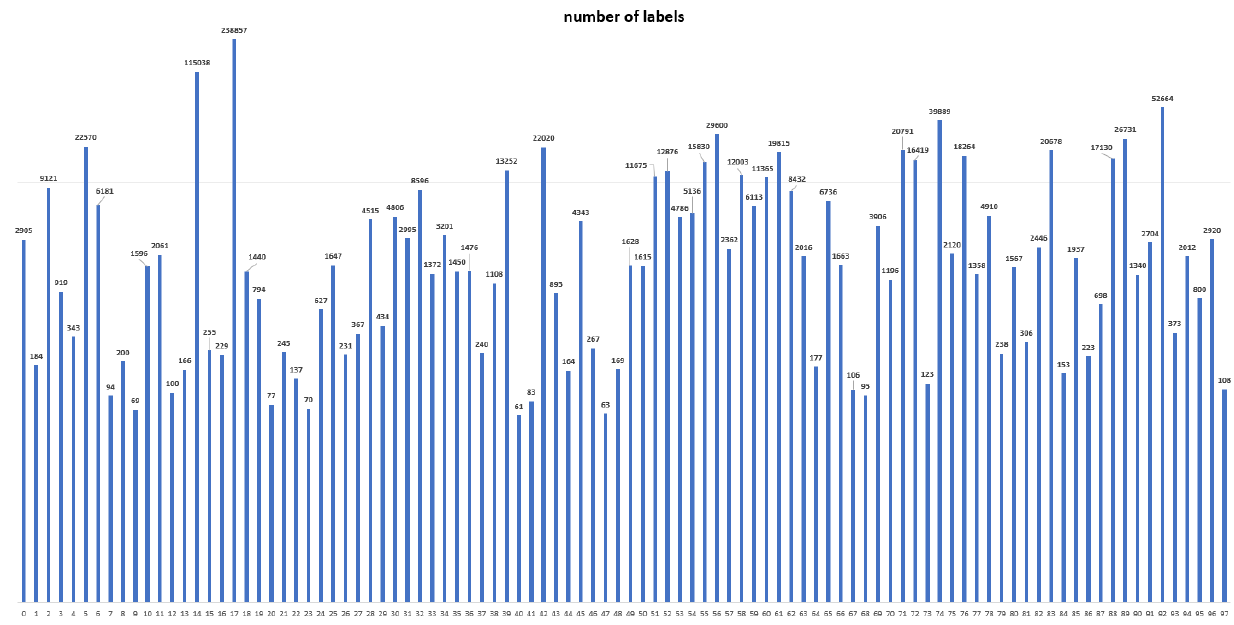
Figure 4. The number of samples for each class (in logarithmic